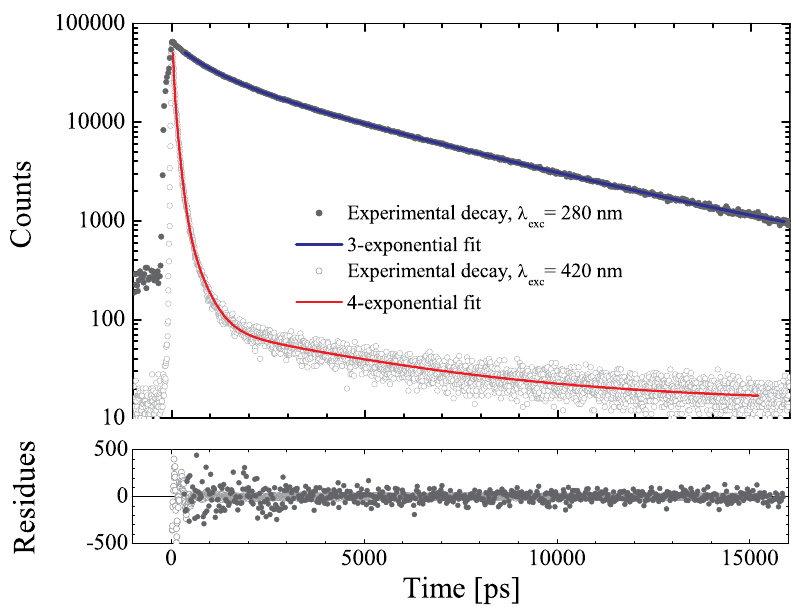
Fig 7. Fluorescence decay patterns of K2T23. Exemplary decay distributions obtainedfor K2T23 dissolved in isopropanol uponexcitationat 280 nm (full dots), and 420 nm (empty circles). The continuous blue line represents the best-fitting curve for the former accordingto a tree-exponential decay function, whilethe red line is the best-fitting curve for the latter to a four-exponentialdecay model. The correspondingresidual plots are reportedin the lower